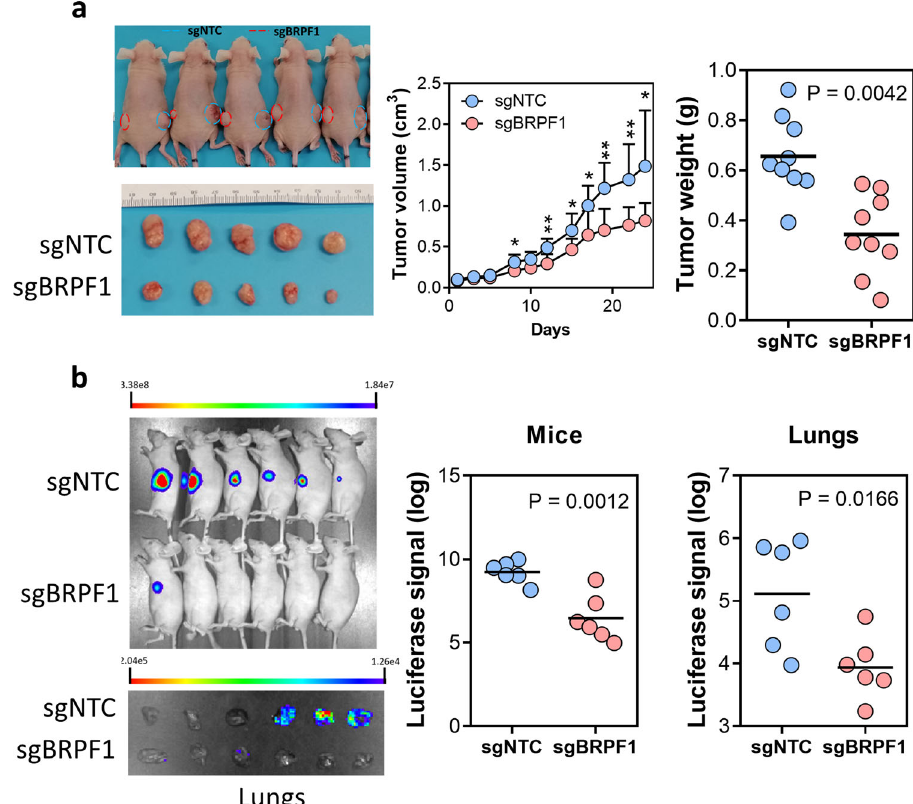
Fig. 4 Knockout of BRPF1 suppressed HCC growth in vivo. a BRPF1 knockout reduced subcutaneous tumor growth in nude mice. The tumor volumes and tumor weights between two groups were compared by paired t -test. n = 9 b Knockout of BRPF1 dramatically suppressed HCC orthotopic tumor growth in the liver and lung metastasis in nude mice. Data were compared by independent t -test. n = 6 * P < 0.05, ** P < 0.01 vs. sgNTC as